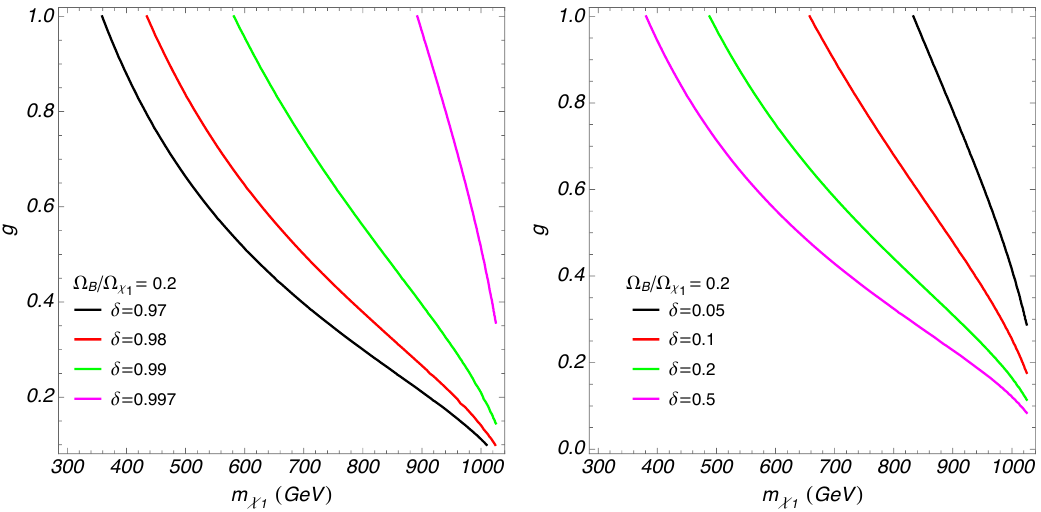
Figure 7 . Contours of constant Ω B / Ω χ ≈ 0 . 2 for varying annihilation coupling g and DM mass 1 m χ and four values of the mass splitting δ in the hierarchical (left) and the nearly degenerate 1 (right) scenarios where annihilation is dominantly p -wave in the limit of m A (cid:29) m S . In analogy